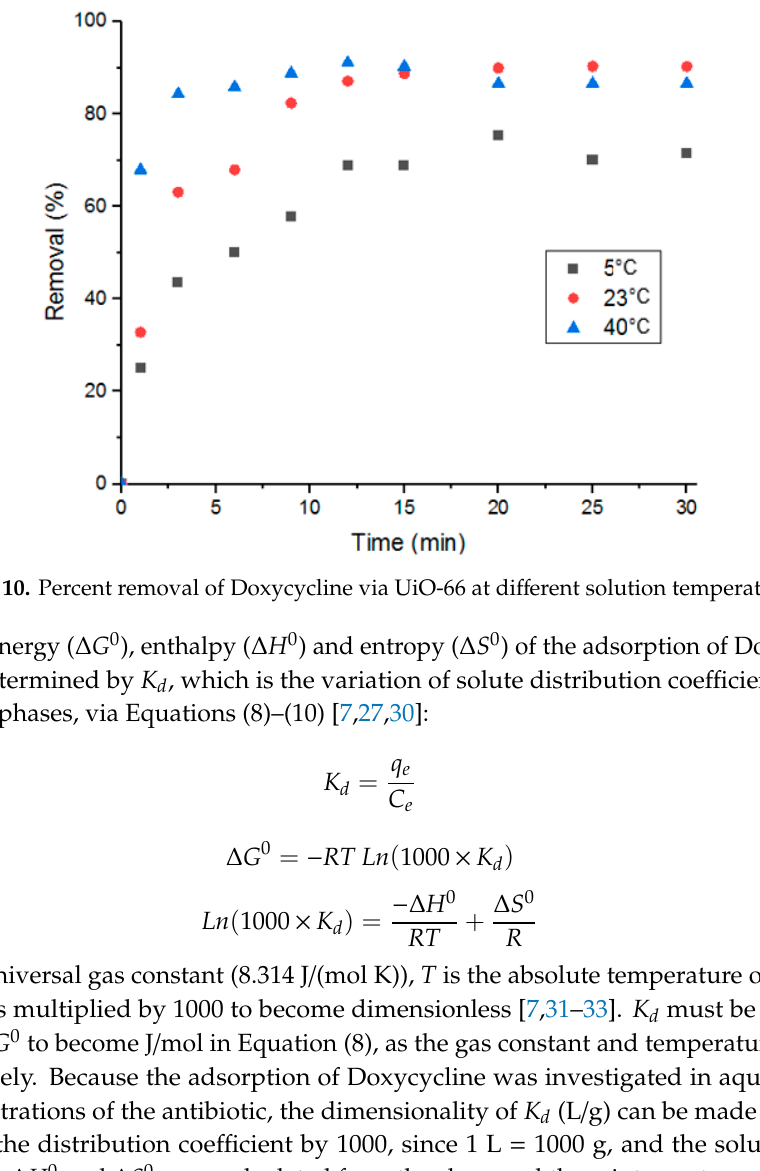
Figure 9. Effect of solution pH on percent removal.